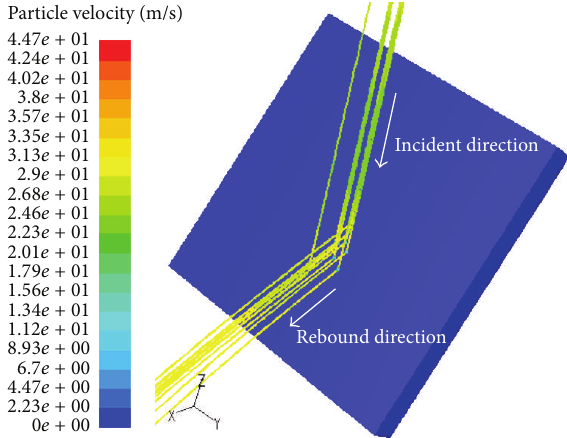
Figure 9: The trajectories of particle collision smooth surface.